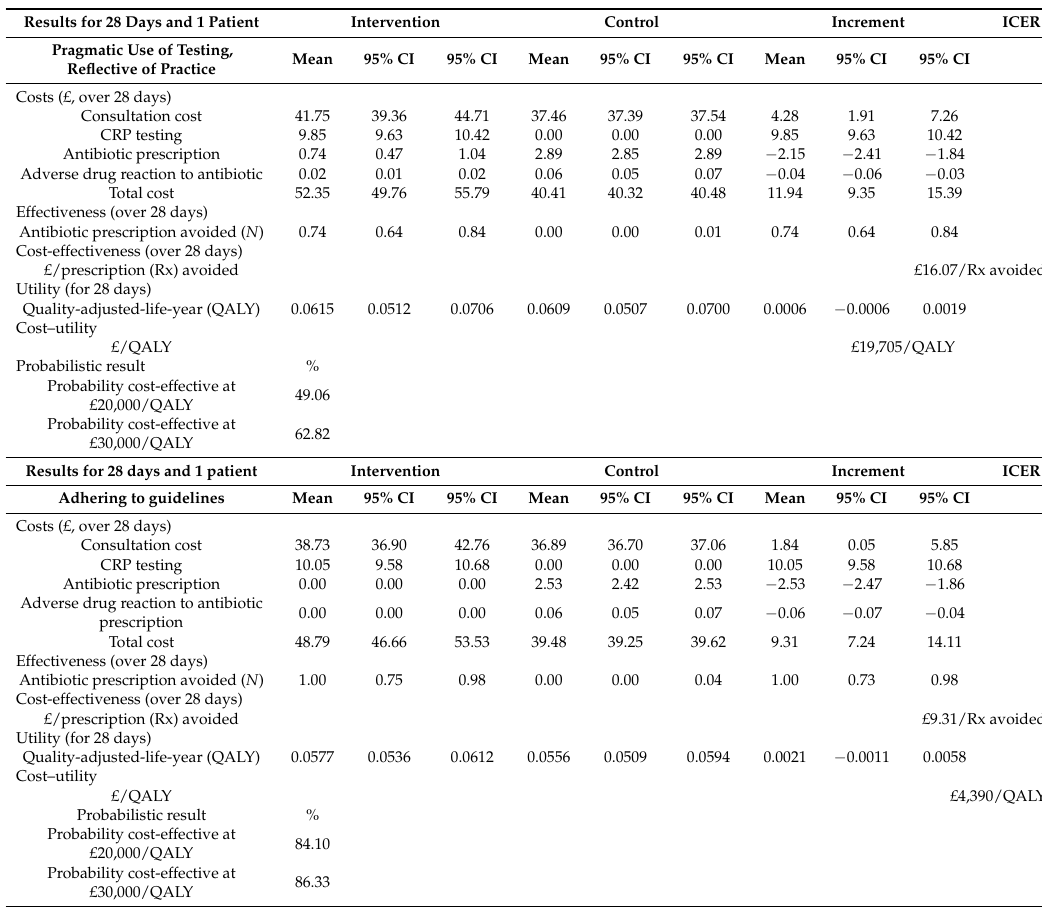
Table 1. Cost-effectiveness of point-of-care (POC) C-reactive protein (CRP) testing for adults with symptoms of acute respiratory tract infection (ARTI) for >12 h where the antibiotic decision is unclear versus immediate antibiotic prescription. CI: Confidence Interval; ICER: Incremental cost-effectiveness